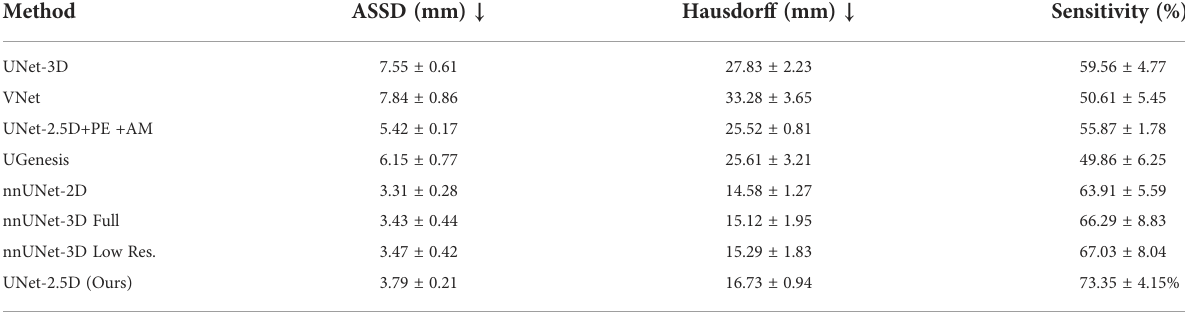
TABLE 3 Comparative results using distance metric as another measure between predicted and groundtruth contours. Method